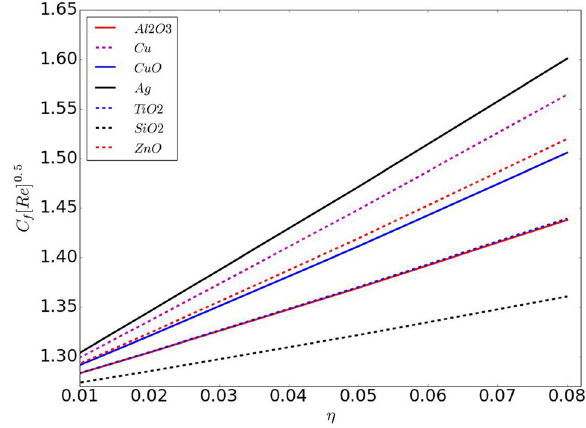
Fig. 19 Temperature profile for various nanofluids with fixed 𝜉 = 0.5 and 𝜙 = 0.05